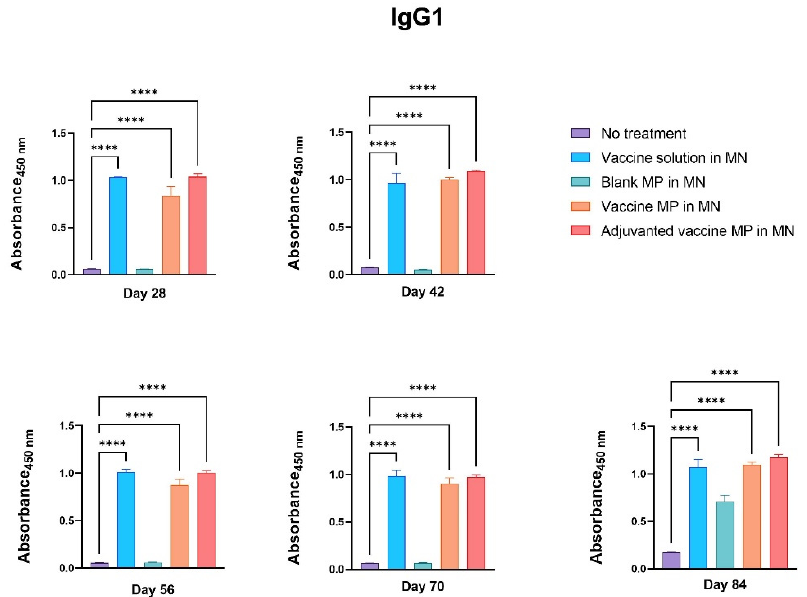
Figure 6. Measurement of Zika-specific IgG1 using ELISA. Mice were immunized via transdermal route with one prime dose on day 0 and two booster doses on days 15 and 29. Mice receiving vaccine solution, vaccine MPs, and adjuvanted vaccine MPs produced significantly higher antibody titers than the untreated control group (days 28, 42, 56, 70, and 84) (data presented as mean ± SEM, n = 5, One-Way ANOVA test followed by Dunnett’s multiple comparison test; ****, p < 0.0001).